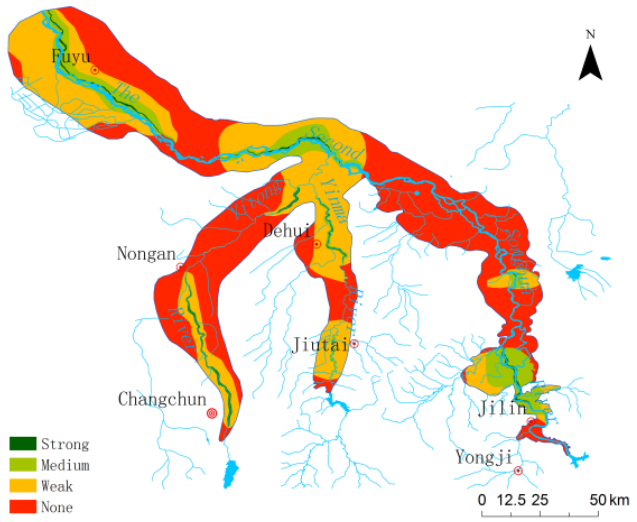
Figure 15. Distribution of the possible influence zone width of surface water.